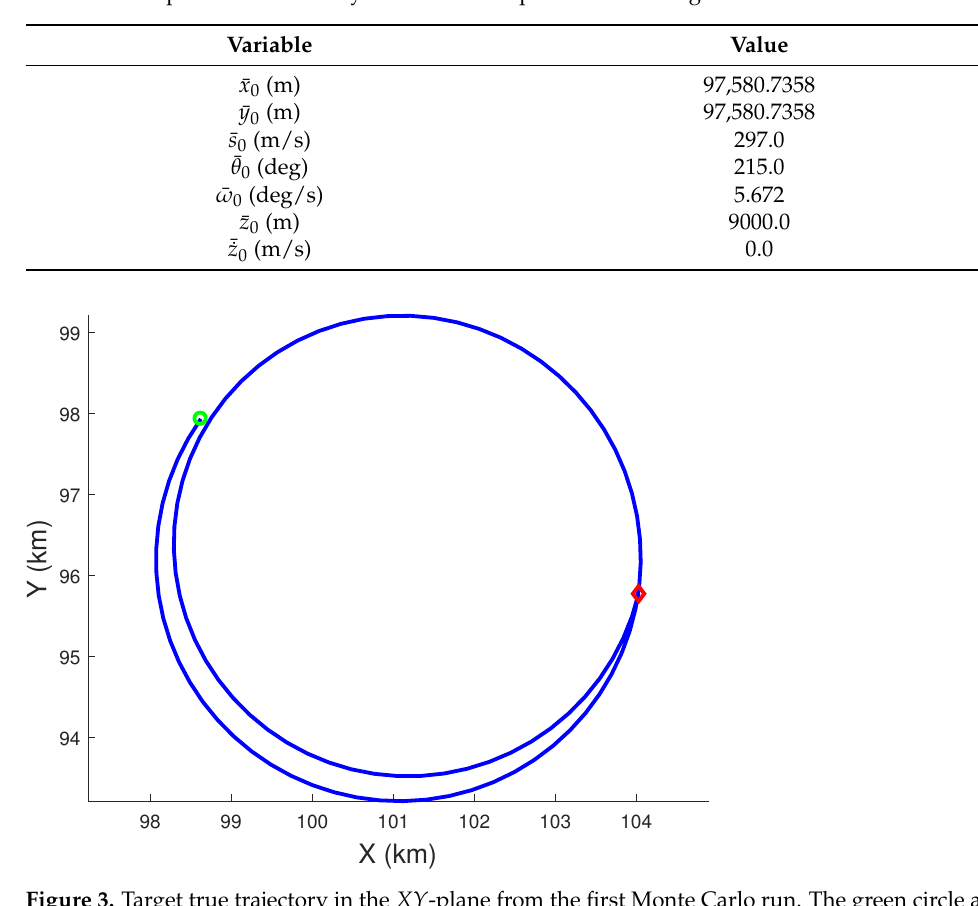
Table 2. Prior polar mean velocity-based 3D state parameters of target.